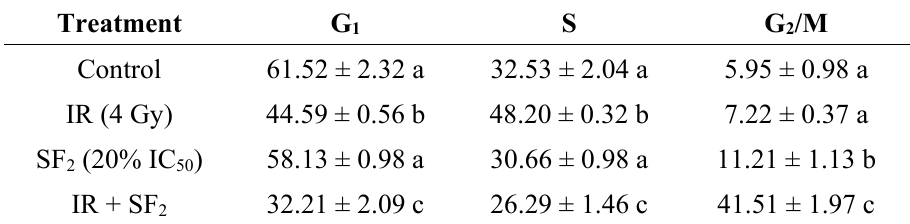
Table 1. Percentage distribution of A549 cells.